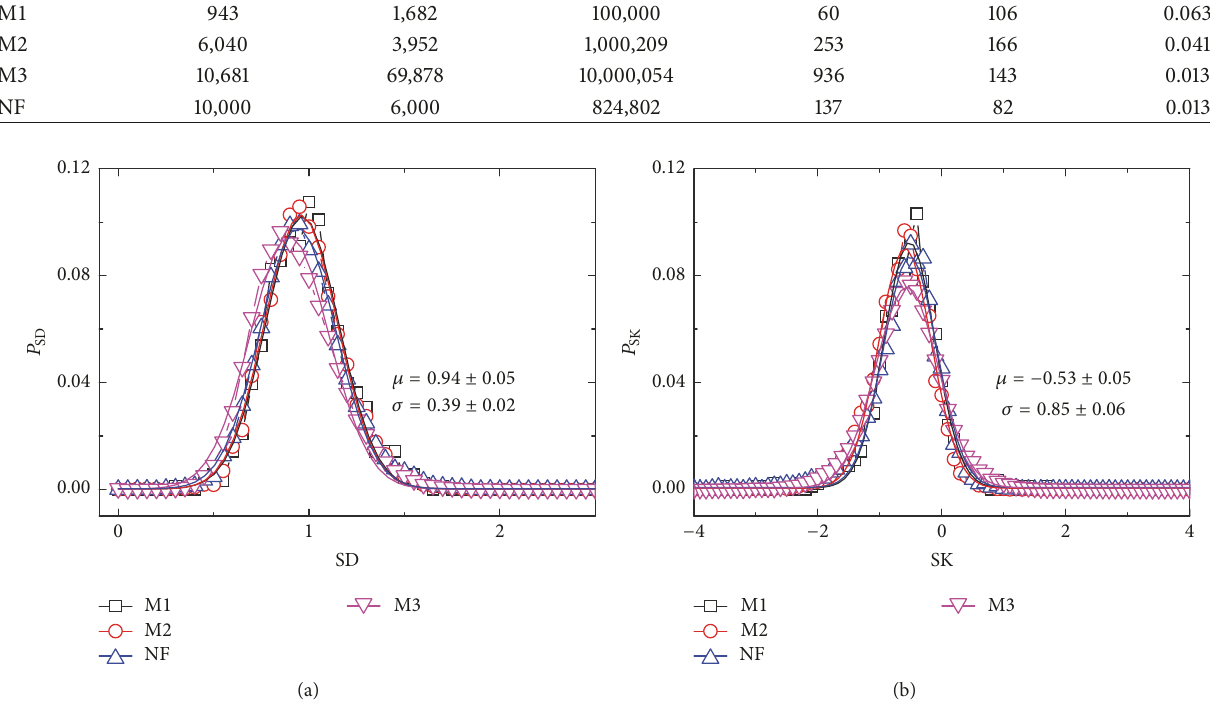
Figure 2: Distribution of the users’ rating magnitude in the M1, M2, M3, and NF datasets. (a) the distribution of users’ standard deviation (SD) and (b) the distribution of users’ skewness (SK) in the four datasets. The statistical features of the four datasets are shown in Table 1. Detailed introduction of the datasets can be found in section Materials and Methods